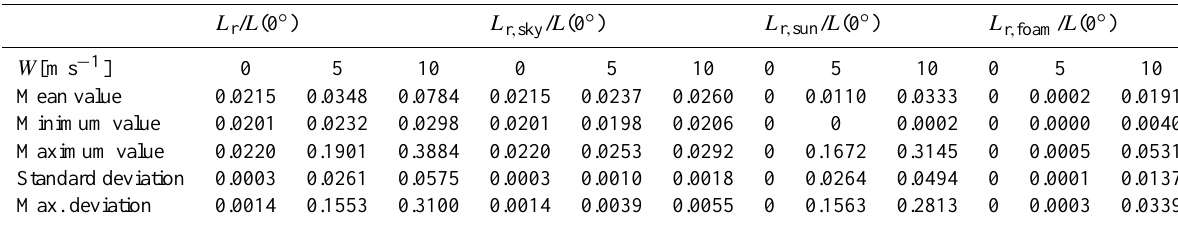
Table 1. Statistical properties of radiance ratios. Deviations are from the mean value. L r / L (0 ◦ ) L r , sky / L (0 ◦ ) Mean value